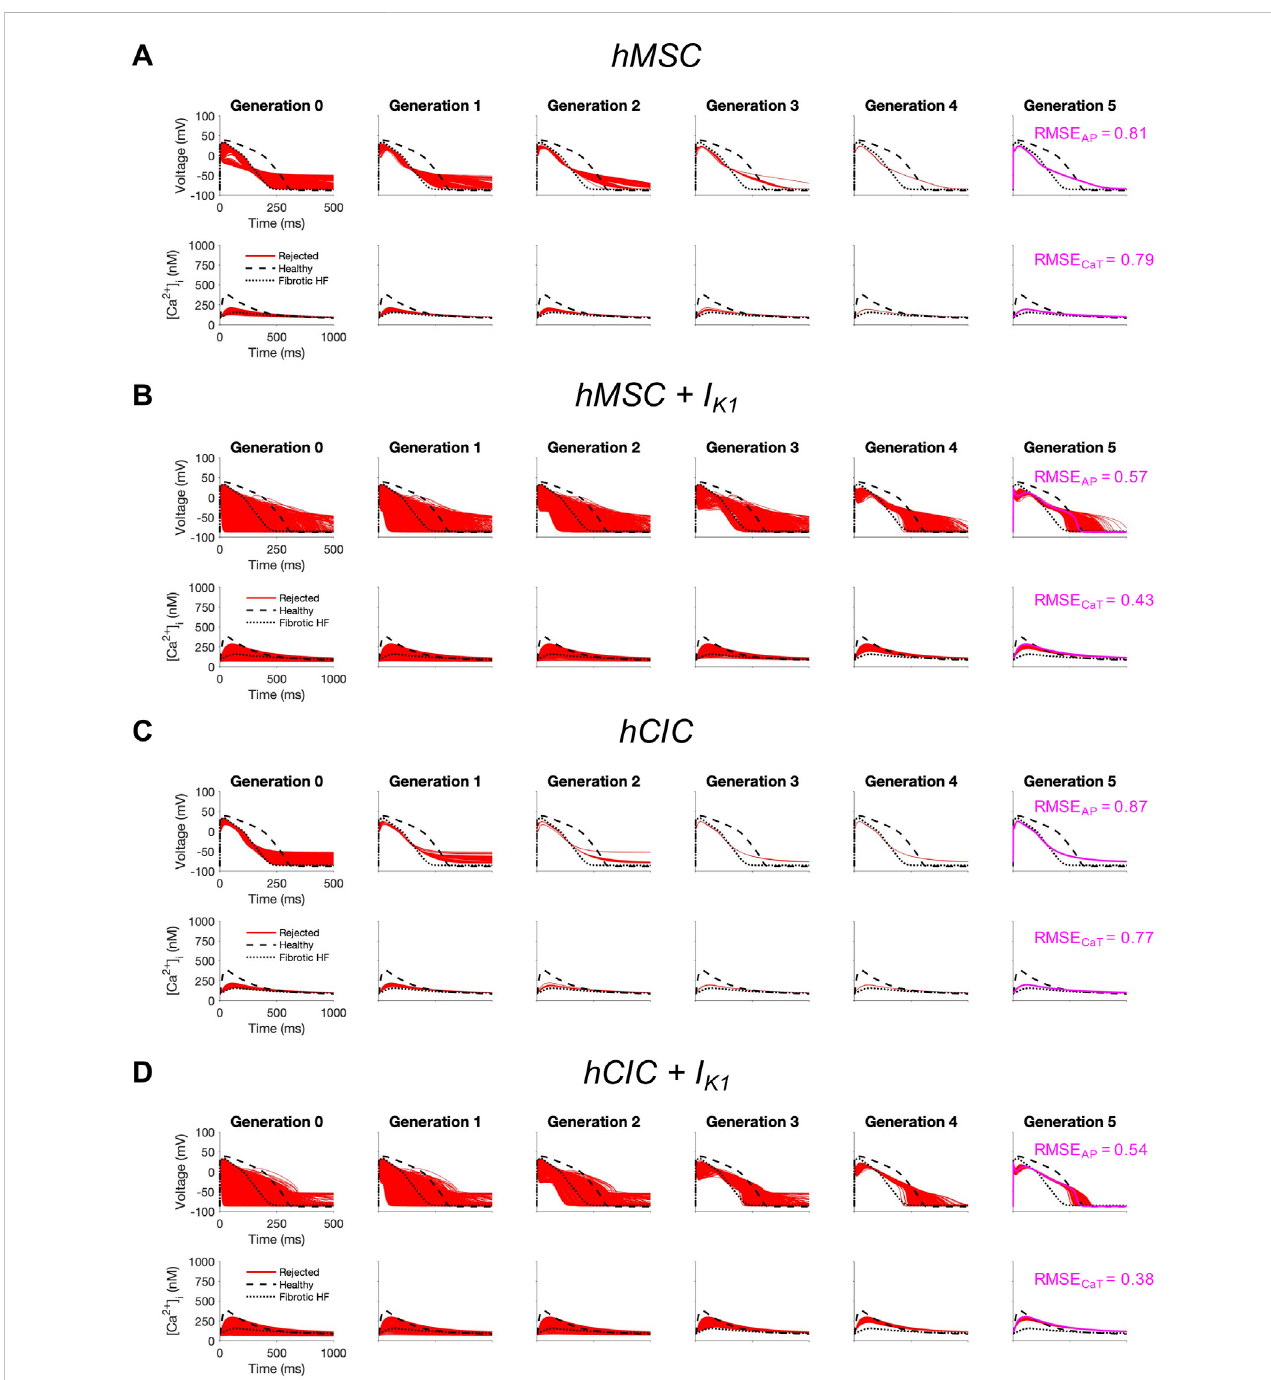
FIGURE 7 Custom engineered human mesenchymal stem cells and c-kit + cardiac interstitial cells expressing cardiomyocyte inward recti fi er channels reduce root mean square error. Initial populations of 2500 (A) control human mesenchymal stem cells (hMSCs), (B) hMSCs expressing cardiomyocyte inward recti fi er channel (I K1 ), (C) control c-kit + cardiac interstitial cells (hCICs), and (D) hCICs expressing I K1 were generated for heterocellular coupling with fi brotic heart failure (HF) cardiomyocytes with pseudo-random perturbations of gap junction conductances, number of coupled cells, and I K1 maximal